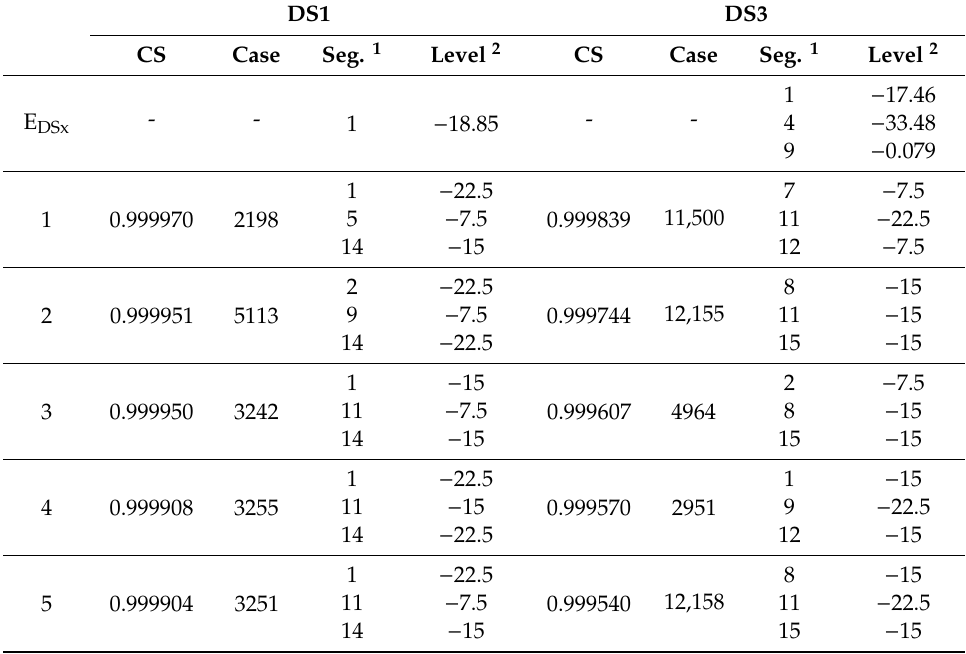
Table 10. The top five damage cases in cosine similarity with the first to fourth natural frequencies of the independent baseline model. DS1 DS3 CS Case Seg. 1 Level 2 CS Case Seg. 1 Level 2 E DSx - Table 8. The top five damage cases in cosine similarity with the first to fourth natural frequencies of the symmetric baseline model. DS1 DS3 CS Case Seg. 1 Level 2 CS Case Seg. 1 Level 2 E DSx